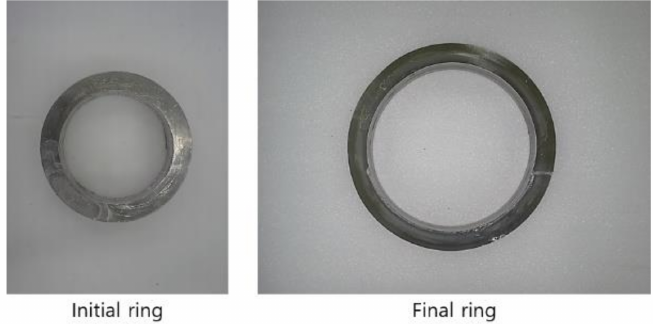
Figure 4. Initial and final Pb75-Sn25 ring.